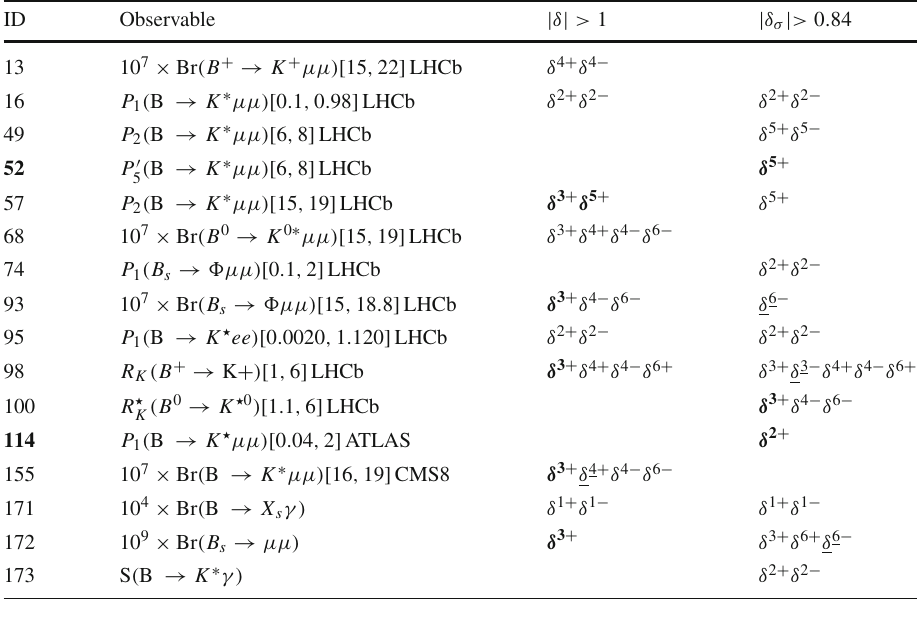
Table 3 Observables from Fig. 6 that present values | δ | > 1 or | δ σ i